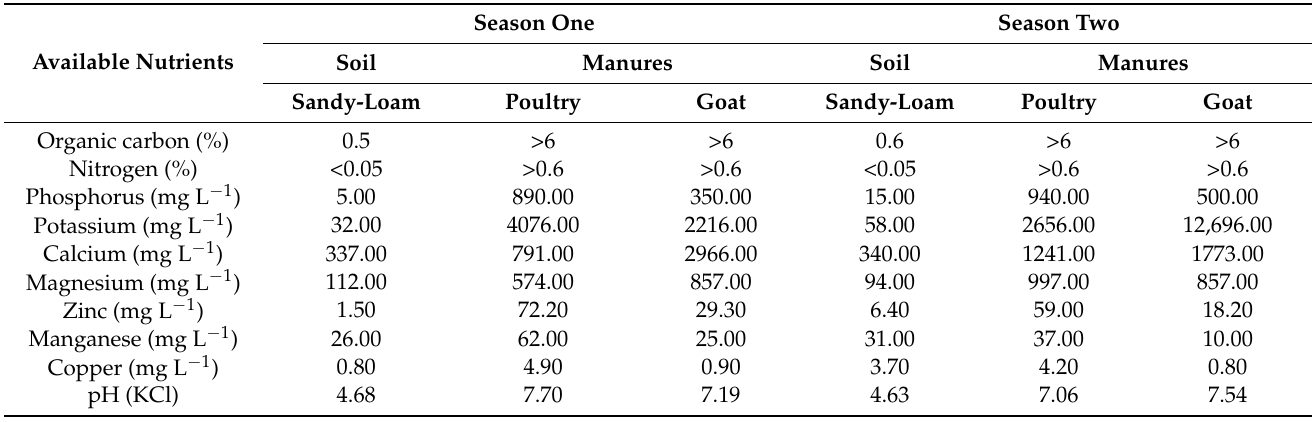
Table 2. Available nutrient content, pH, organic carbon and total nitrogen of soil and manures used in this study. Season One Season Two Available Nutrients Soil Manures Soil Manures Sandy-Loam Poultry Goat Sandy-Loam Poultry